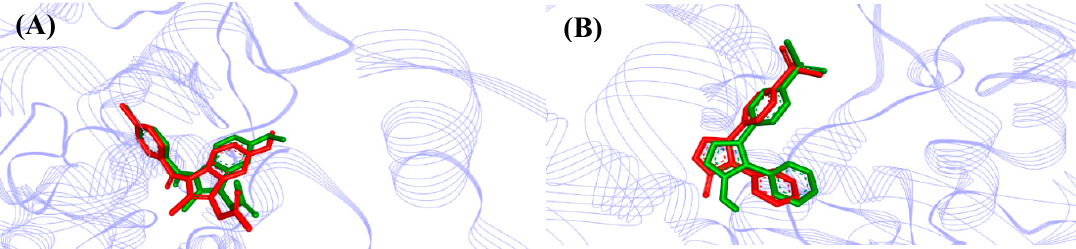
Figure 6. AutoDock validation of ( A ) COX-2 ( Mus musculus , PDB 4COX) and ( B ) COX-2 ( Homo sapiens , PDB 5KIR) with respective crystallographic ligands.